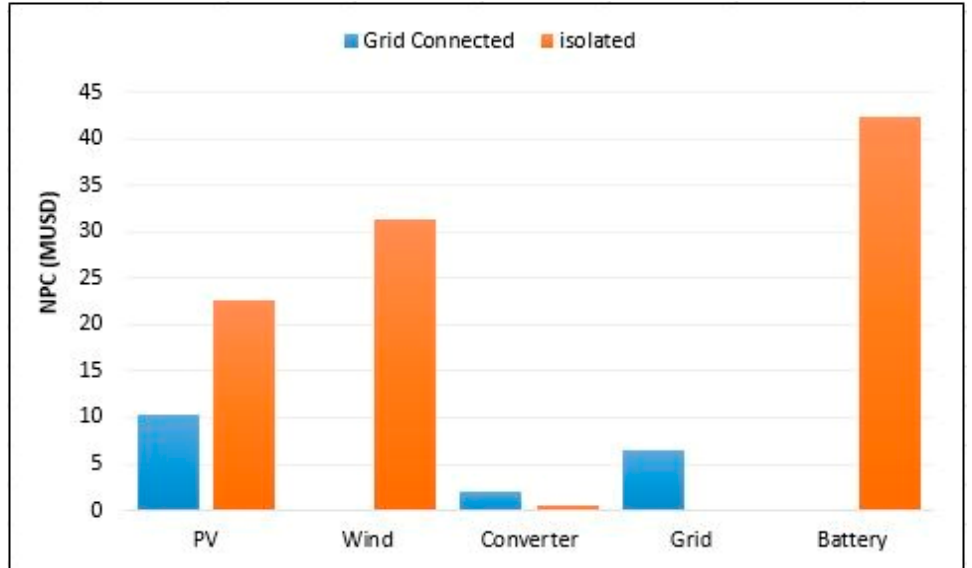
Figure 7. Comparing the net present cost of grid-connected and isolated scenarios (G1 & I1) categorized by components .